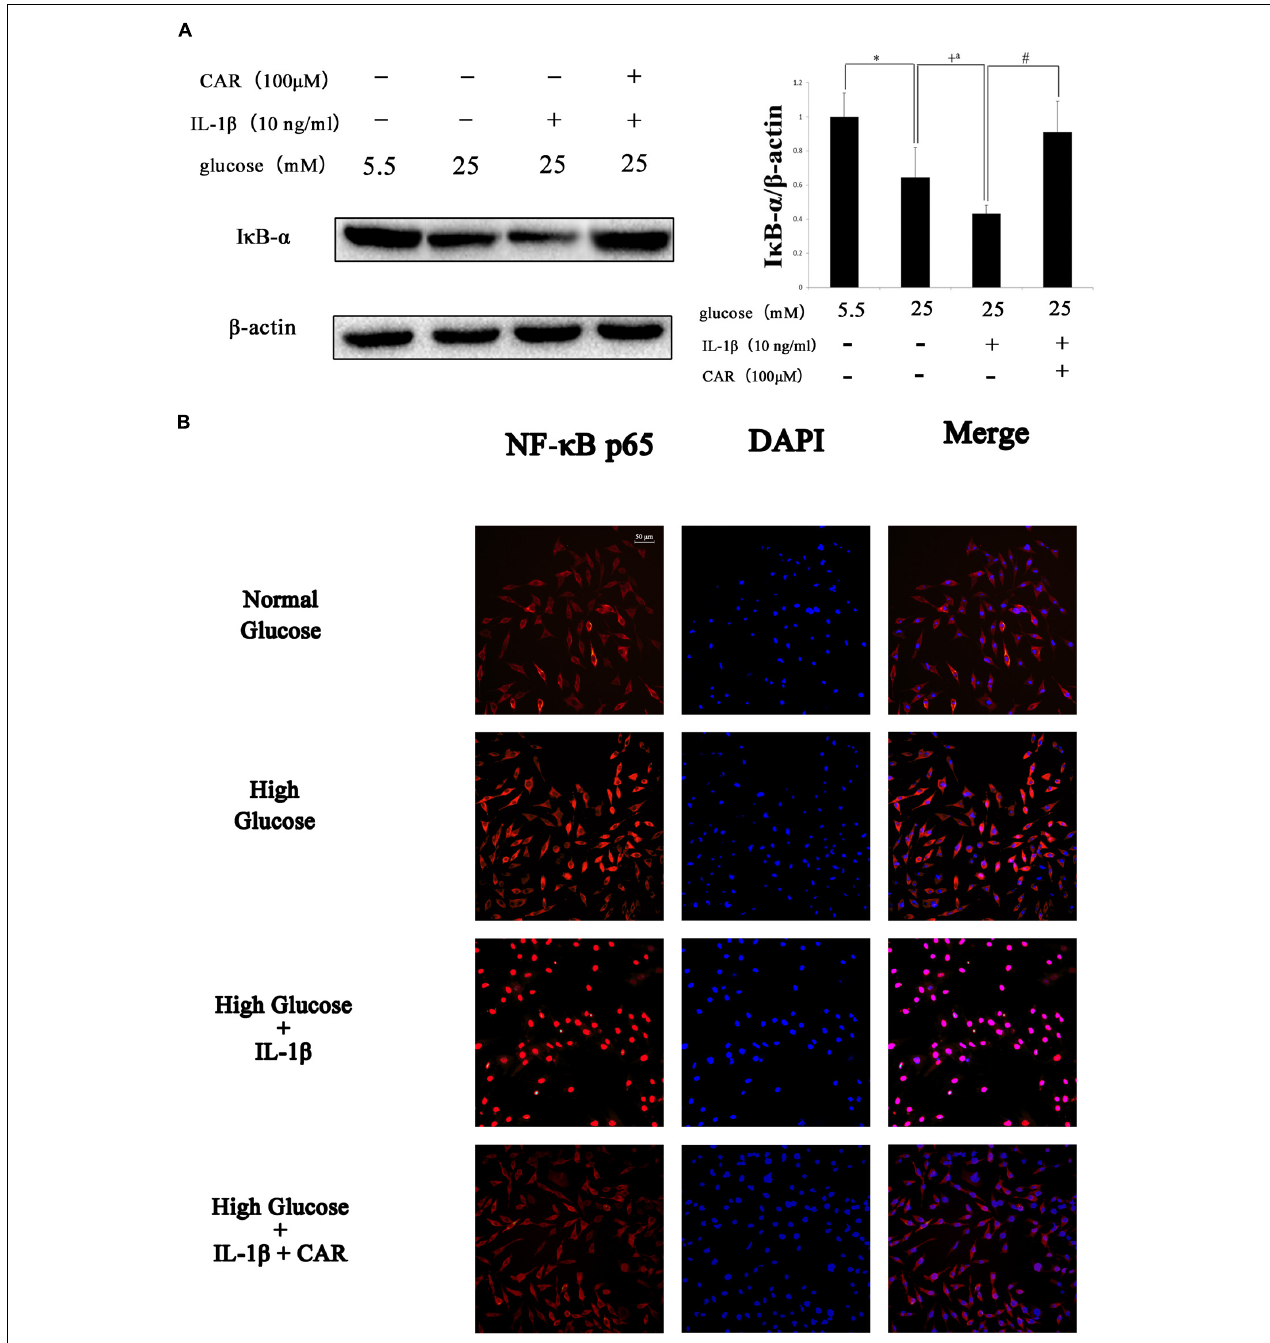
FIGURE 7 | Western blotting and immunofluorescence results of NF- κ B p65 in FLSs. (A) Western blotting results of I κ B- α . Differences between the groups were significant ( ∗ P < 0.001, + P < 0.001, + a P = 0.002, # P < 0.001). One-way ANOVA, n = 3; means with 95% confidence intervals. (B) Effects of CAR on nuclear translocation of NF- κ B p65 in IL-1 β -induced FLSs under the high glucose condition. The FLSs were immunostained with anti-NF- κ B p65 rabbit antibody (red) and visualized by confocal microcopy. Cell nuclei were defined by DAPI (blue). Scale bar, 50 µ